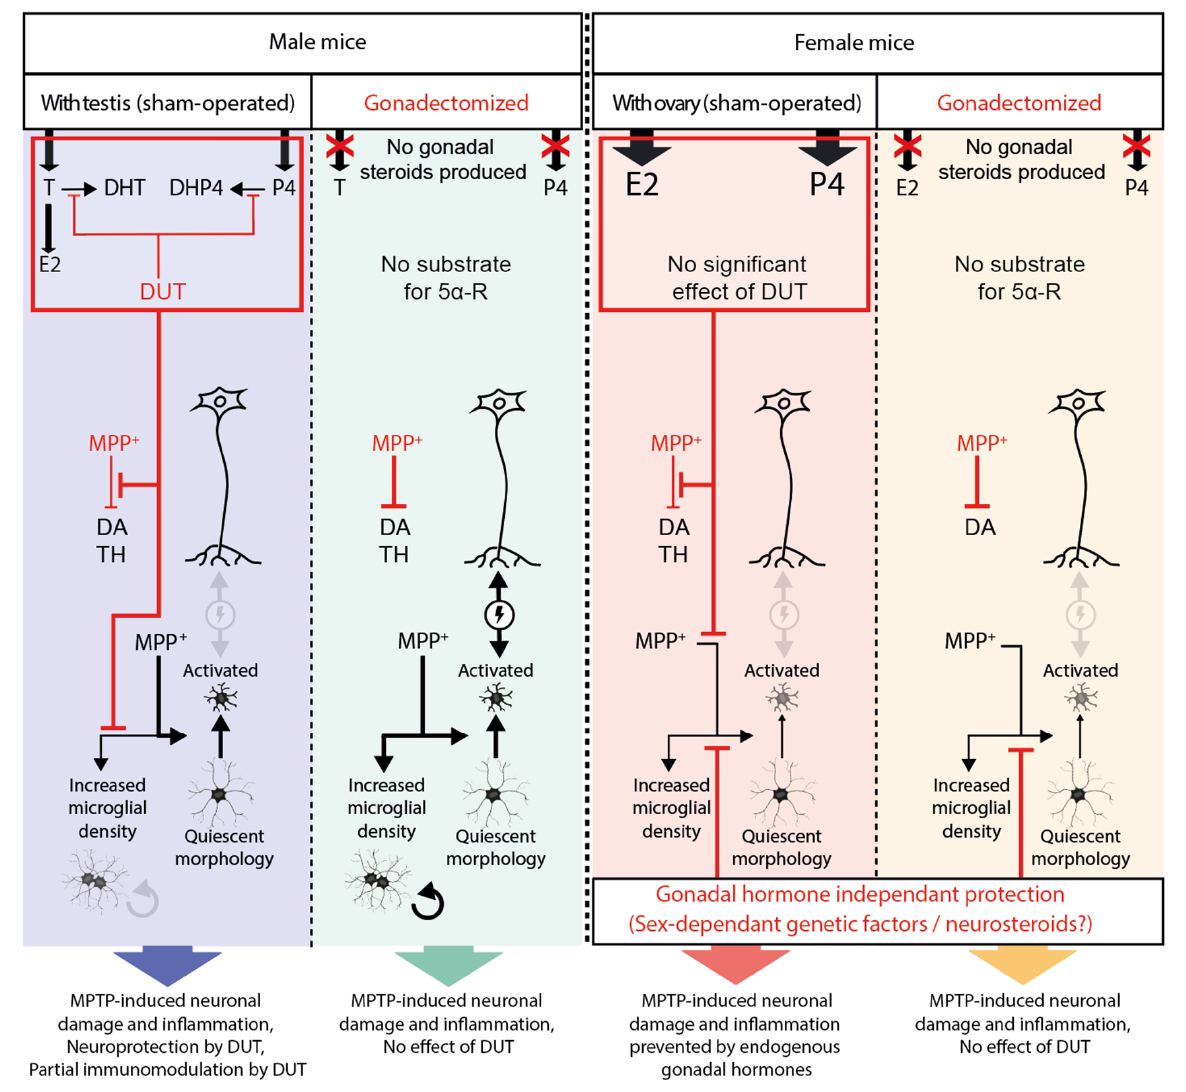
Figure 5. Schematic summary of the results of the present study. Black arrows represent induction, and their thickness shows their significance. Red lines represent inhibition.